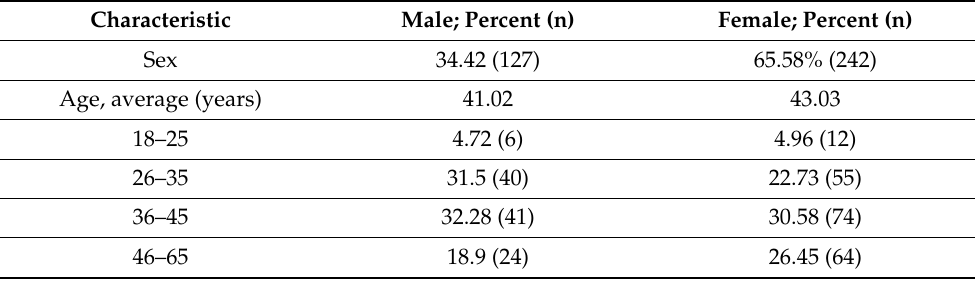
Table 2. Study Population; Sex and Age Range Distribution.